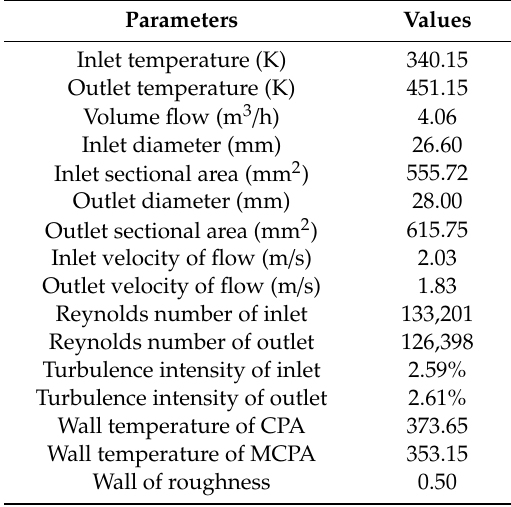
Table 4. Basic setting parameters and boundary conditions of cooling